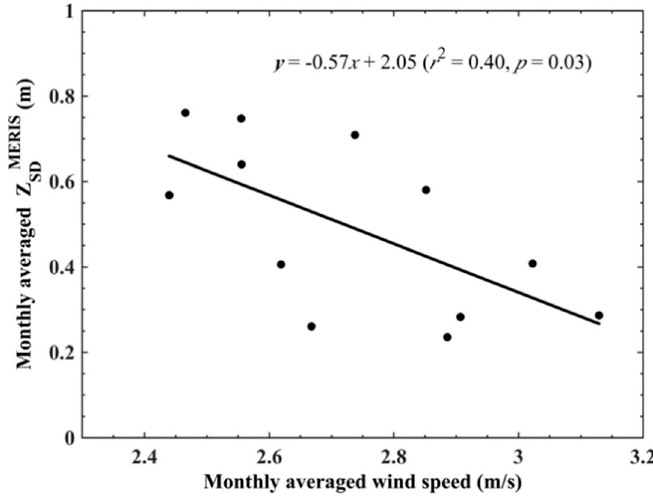
Figure 13. Linear relationship between monthly averaged wind speed and MERIS-derived Z SD of the entire lake, from 2003 to 2011.